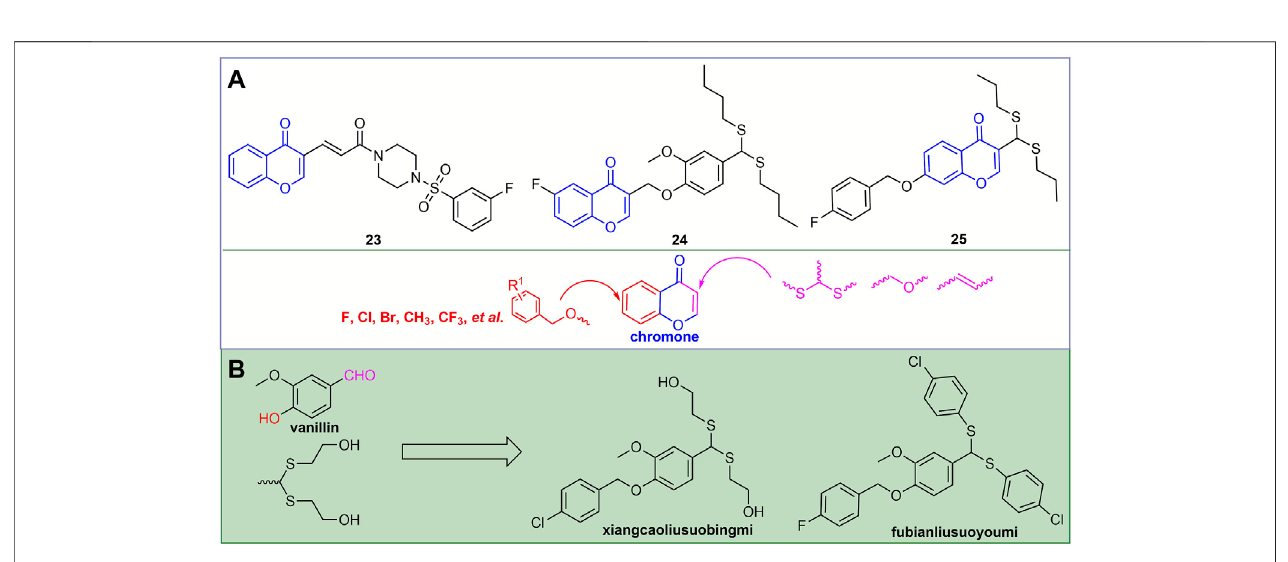
FIGURE 7 | Structures of representative chromone derivatives in antiviral activities (A) . Discovery of novel antiviral agents xiangcaoliusuobingmi and fubianliusuoyoumi (B) .